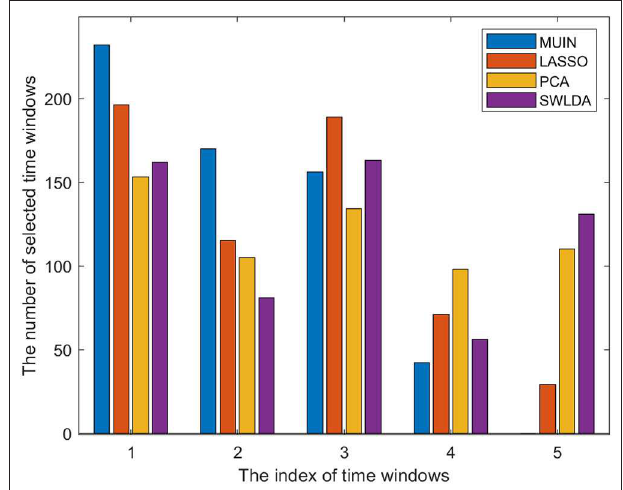
FIGURE 4 | The bar chart represents the total number of selected time windows for the proposed algorithms in datasets 1–3. (The meaning of time window indexes can be found in Section Multi-time segmenting and temporal band-pass filtering).